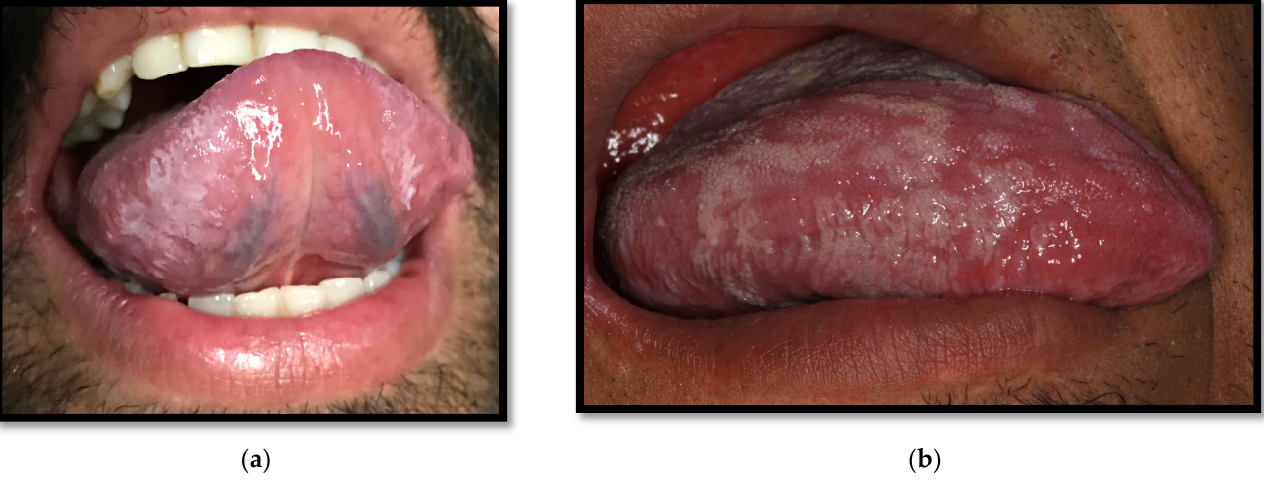
Figure 11. ( a ) Oral hairy leukoplakia on the underside of the tongue; ( b ) Oral hairy leukoplakia on the lateral border of the tongue.